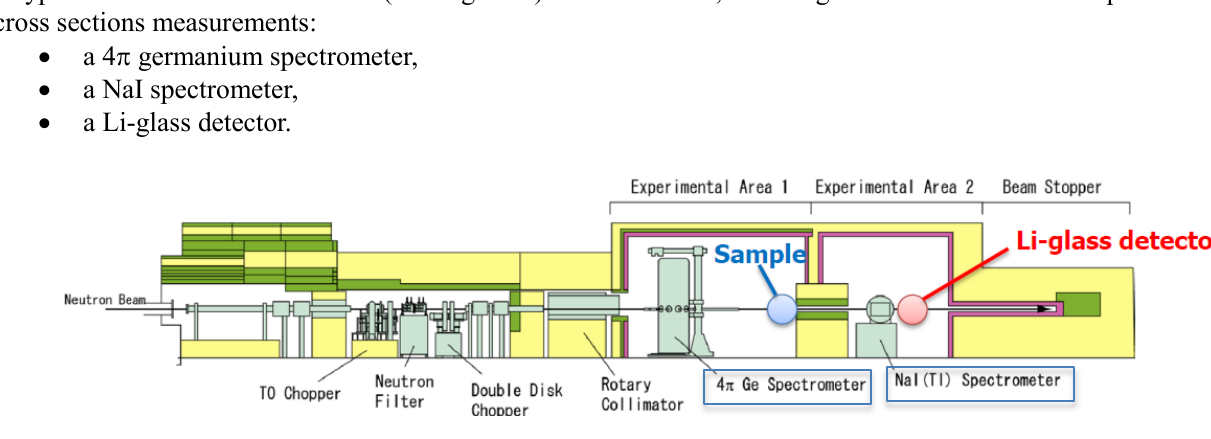
Figure 1. ANNRI experimental